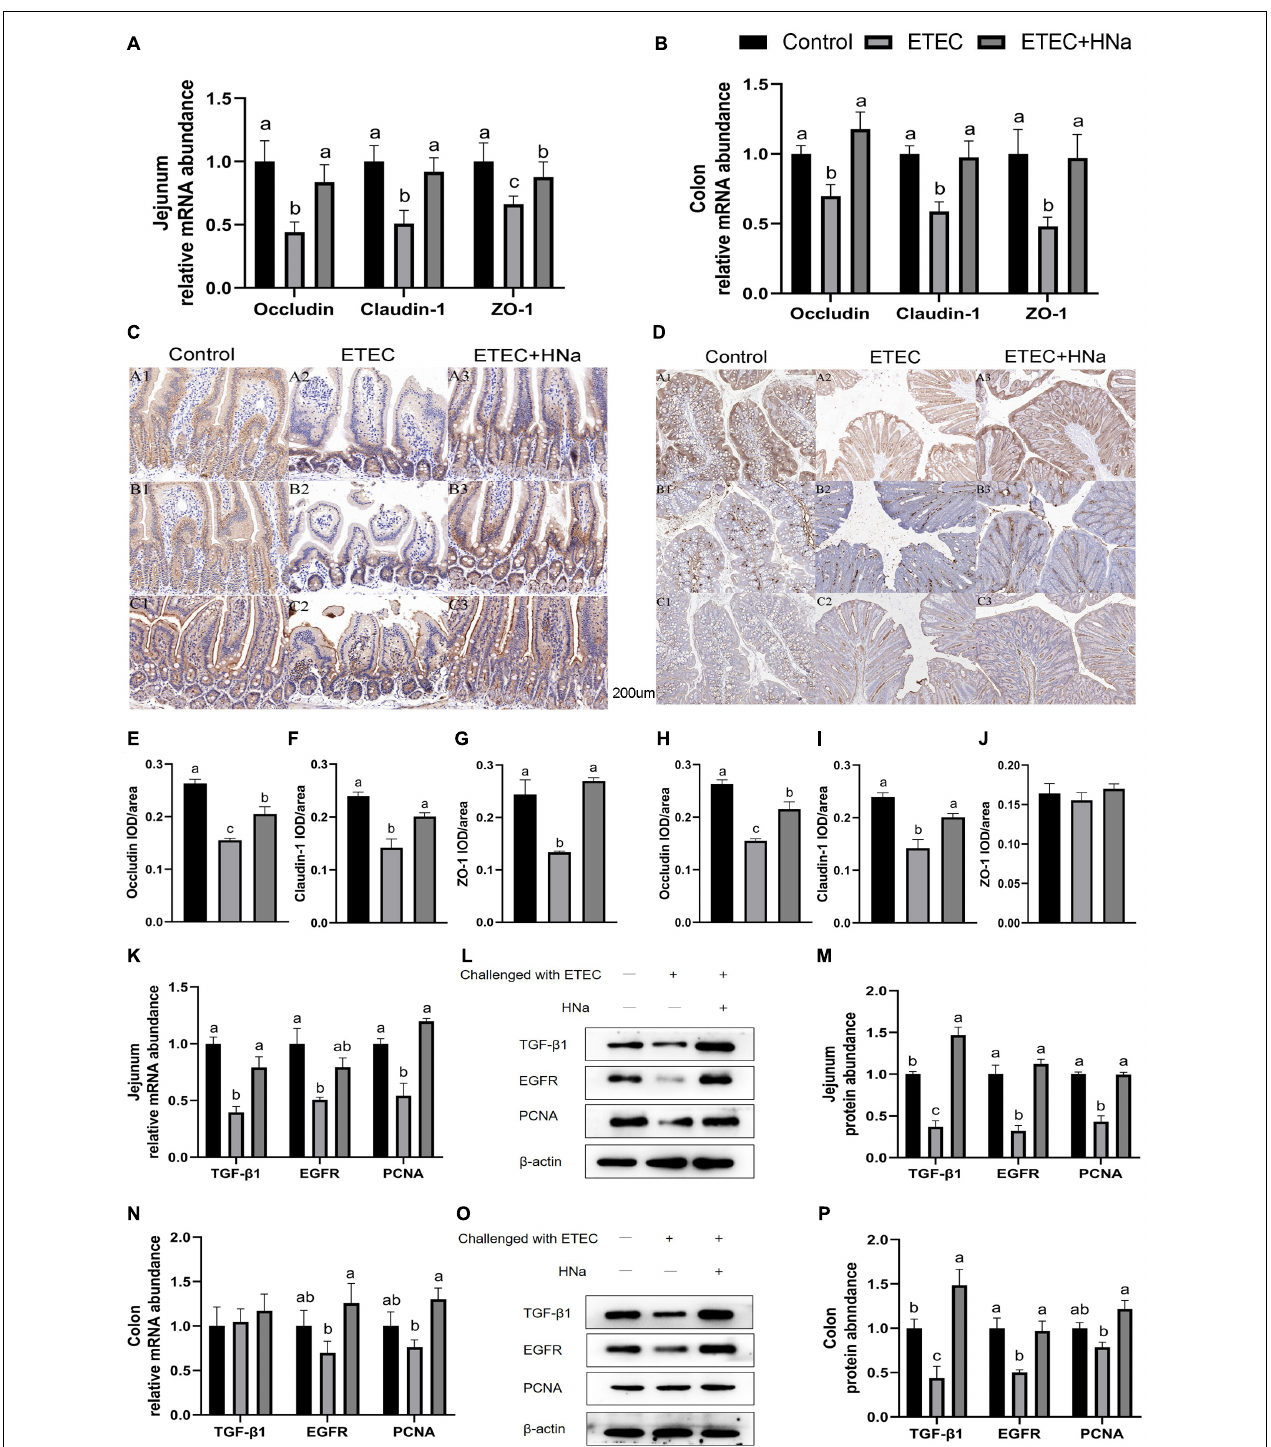
FIGURE 3 | Effects of sodium humate on the mRNA and protein expression of tight junction proteins and intestinal epithelial cell repair factors in jejunum and colon of ETEC K88-infected mice. The mRNA expression of occludin, claudin-1, and ZO-1 in the jejunum (A) and colon (B) . Immunohistochemical staining of occludin, claudin-1, and ZO-1 in the jejunum (C,E–G) and colon (D,H–J) tissues (200 µ m). The mRNA and protein expression of TGF- β 1, EGFR, and PCNA in the jejunum (K–M) and colon (N–P) of mice. All of the data are expressed as the mean ± SEM. Different superscript lowercase letters within each group indicate significantly different ( P <